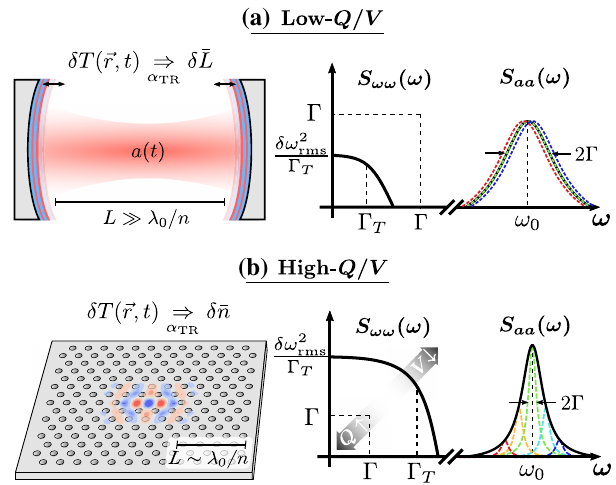
FIG. 1. Comparison of thermorefractive noise (TRN) in macro- scopic resonators (a) and microcavities (b). Mode-averaged ¯ T temperature fluctuations δ in large cavities induce refractive ¯ L index noise δ ¯ n (and, thus, path length changes δ ) due to the dn=dT . The mirrors ’ nonzero thermo-optic coefficient α TR ¼ ¯ T large mode volume V reduces δ , yielding a narrow-band resonant frequency noise spectrum S ωω ð ω Þ and an rms resonant ≪ Γ , the cavity half-linewidth. This frequency fluctuation δω rms nondominant thermal noise inhomogeneously broadens the intra- ω Þ . Decreasing V increases both the cavity field spectrum S aa ð magnitude δω and bandwidth Γ of TRN, while increasing the T rms resonator quality factor Q ¼ ω 0 = 2 Γ causes both quantities to exceed Γ . TRN, therefore, becomes a dominant source of homogeneous broadening in wavelength-scale high- Q=V micro- cavities, leading to thermal dephasing and reduced resonant excitation efficiency of the cavity field a ð t Þ